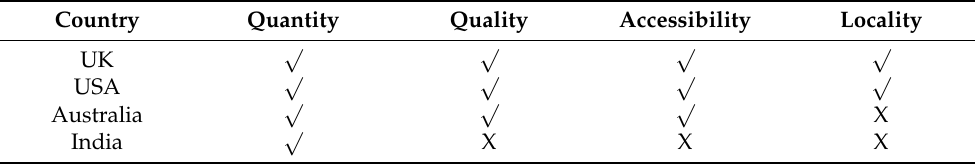
Table 3. Dimensions of Open Space Standards.